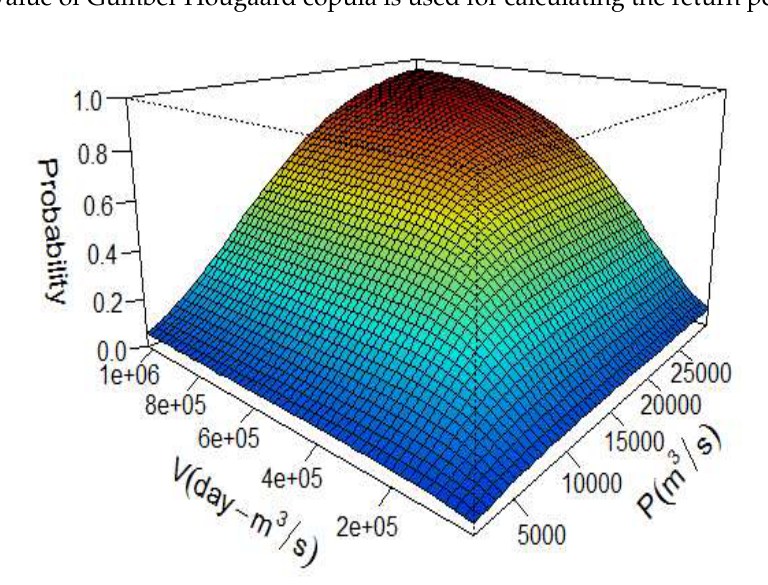
Figure 5. The c.d.f value of Gumbel-Hougaard Copula.